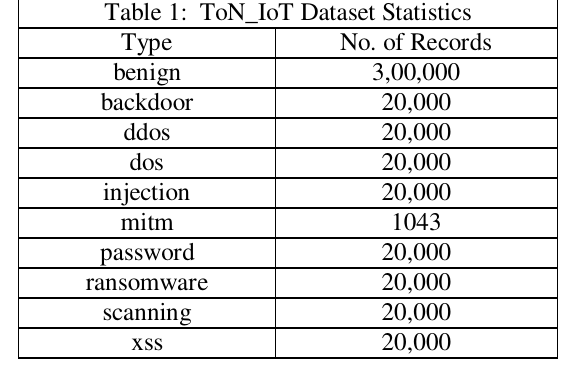
Table 1: ToN_IoT Dataset Statistics